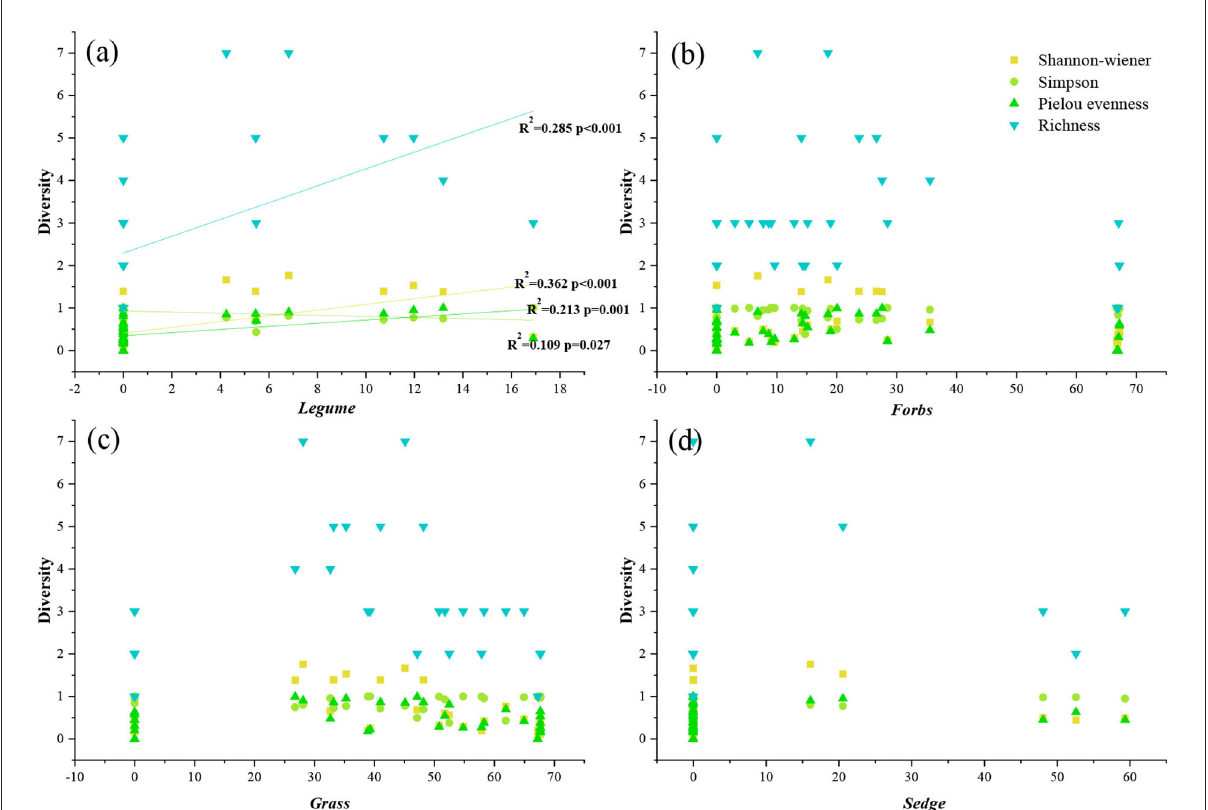
FIGURE3 Relationships between PFGs and diversity. The solid line indicates a significant correlation ( p < 0.05). The distribution of (a–d) represents the correlation analysis of legumes, forbs, grasses, sedges, and diversity